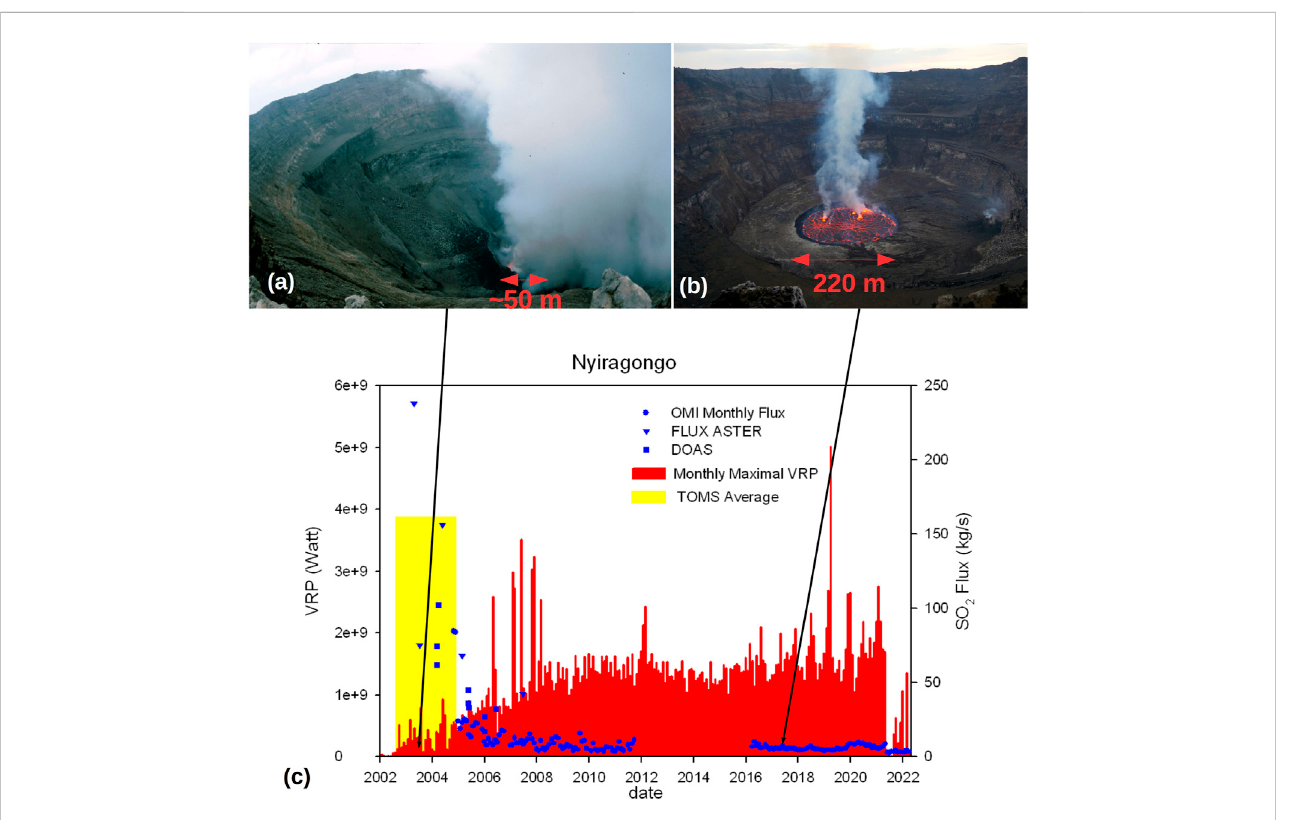
FIGURE 3 (A )HeavilyfuminglavalakeofNyiragongoinJune2003intheearlystageofitsformation(photo: M.Caillet). (B)